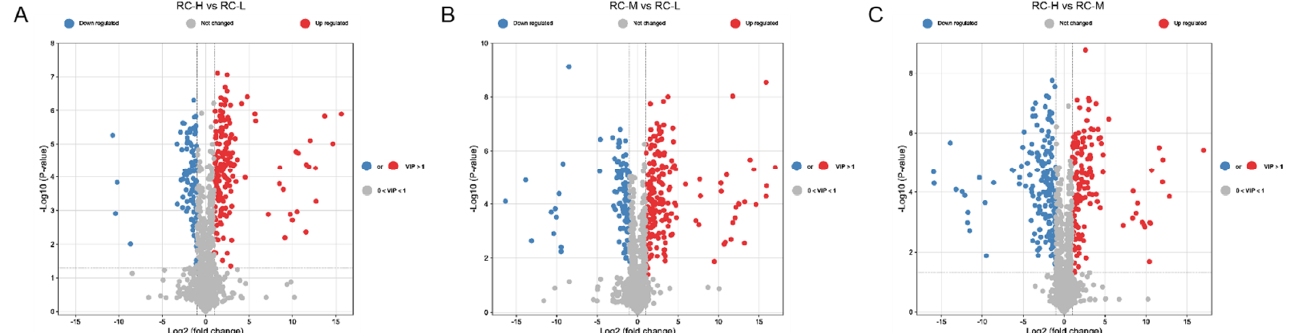
Figure 6. Differential metabolite analyses for RC-H vs. RC-L, RC-M vs. RC-L, and RC-H vs. RC-M with the criteria setting by simultaneously meeting variable importance in project (VIP) value > 1, |log 2 (fold change)| ≥ 1, and p -value < 0.05, plotted by volcano maps. Red and blue dots denoted upregulated and downregulated differential metabolites, respectively; gray dots represented non-differential metabolites. Upregulation denotes that the content of a metabolite in RC increased with elevation between two altitudes, and the opposite for downregulation. ( A ): RC-H vs. RC-L; ( B ): RC-M vs. RC-L; ( C ): RC-H vs.